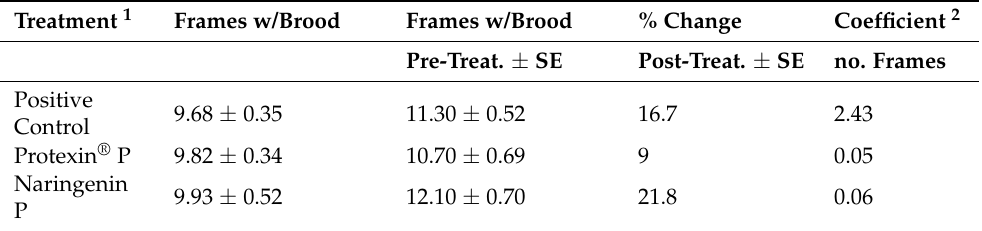
Table 7. Effect of spring 2018 treatments on number of frames containing brood per colony one– two days pre-treatment and nine weeks post-treatment with the prebiotic naringenin or probiotic Protexin ® . Coefficients indicate how the number of frames with brood change changed relative to the positive control. Means are from 33–34 colonies per treatment.